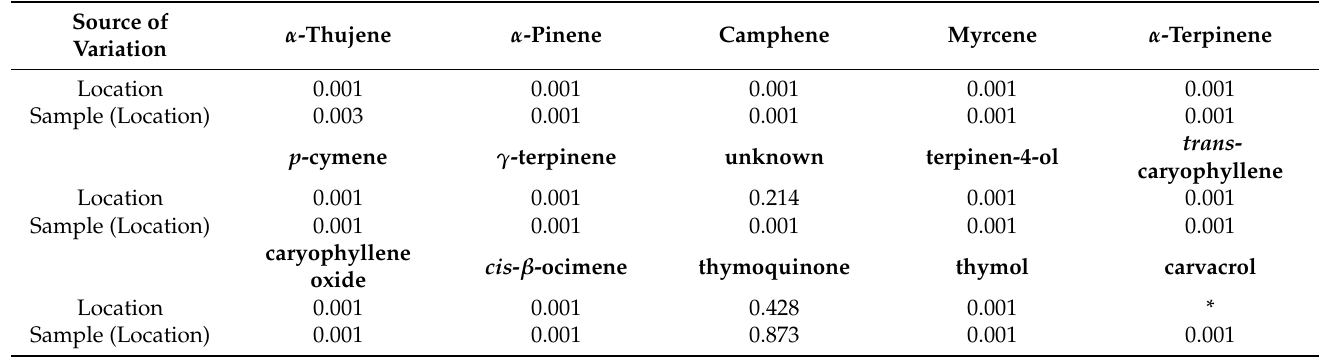
Table 4. ANOVA p -values that show the significance of the effects of location and samples (location) on 15 constituents of S. pilosa . * = no data from